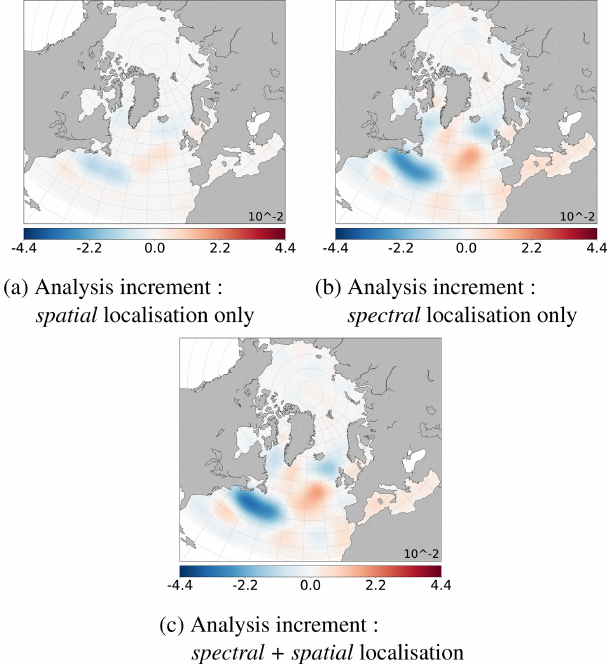
Figure 6. Ensemble mean of large-scale part of the analysis incre- ments (SSH in metres), with l ∈ [0 , l c ], l c = 34: (a) obtained af- ter spatial localisation only and then filtered; see Eqs. (6) and (3); (b) obtained after spectral localisation following Eq. (7); (c) ob- tained after multiscale analysis (spectral + spatial localisation; see Sect. 4.1.2) (to be compared to the large-scale true anomaly, Fig.